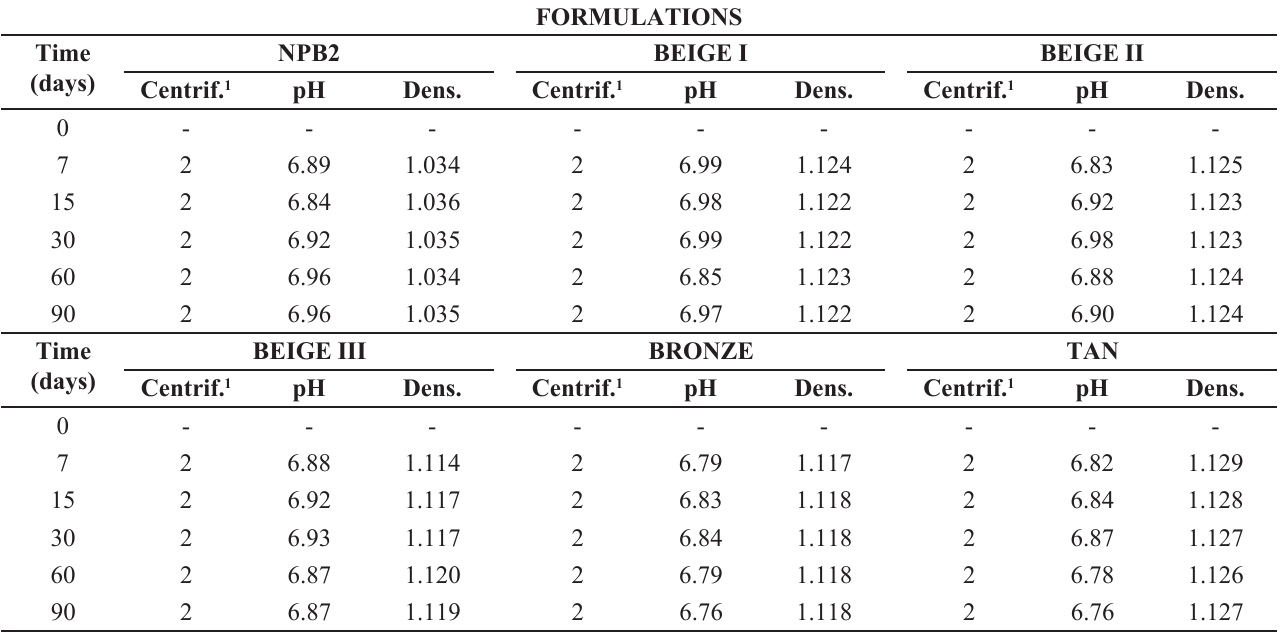
TABLE XII - Results of centrifugation tests (Centrif.), pH and density (Dens.) of the NPB2 base and corrective makeup stored at 5.0 ± 2.0 ºC for up to 90